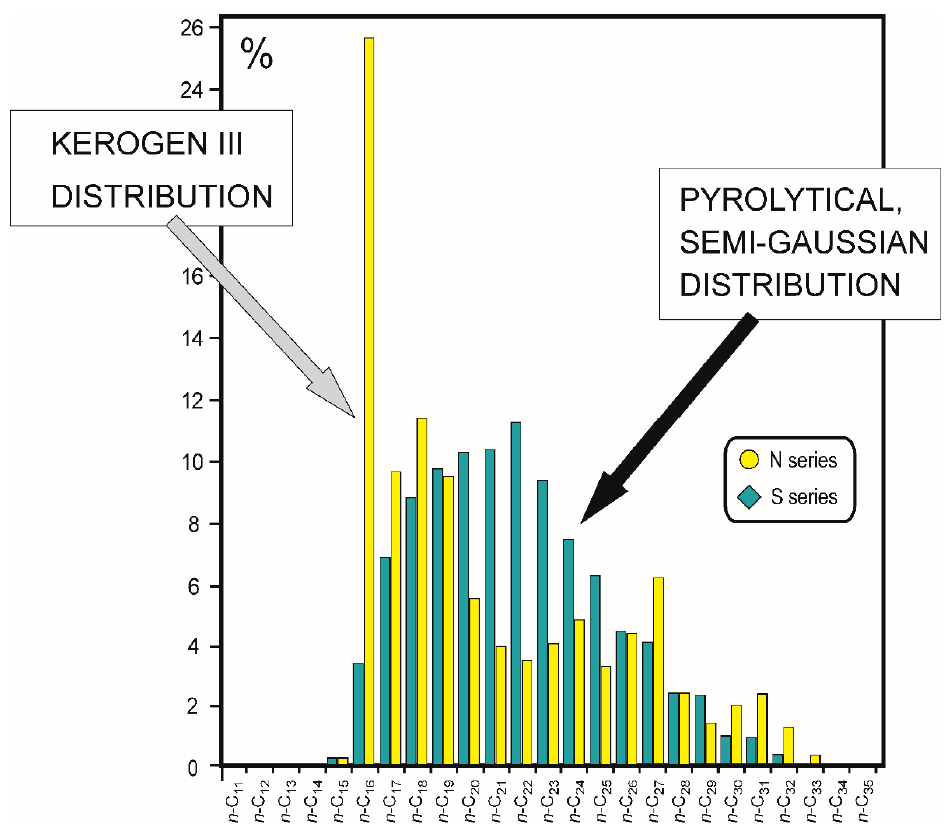
Figure 10. Comparison of n -alkane profiles from the northern and southern parts of the Jas-Mos mining area with changes caused by heating indicated.